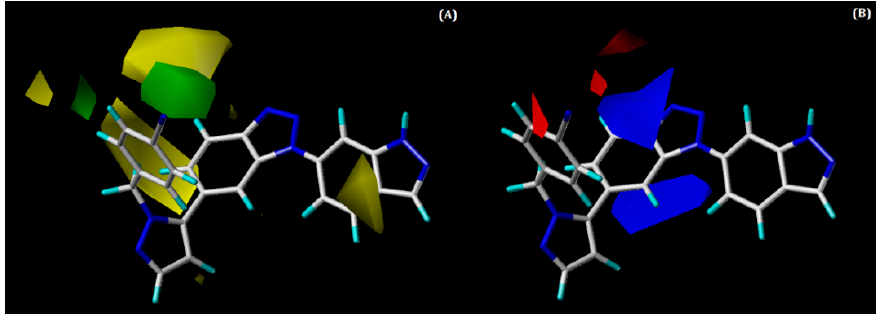
Figure 5. Contour maps for the selected CoMFA model. ( A ) Steric contour map; ( B ) electrostatic contour map; green contour shows the region is favourable for bulky substitutions, and yellow contours show the region is unfavourable; blue contours favour electropositive substitutions, whereas red contours favour electronegative substitutions.